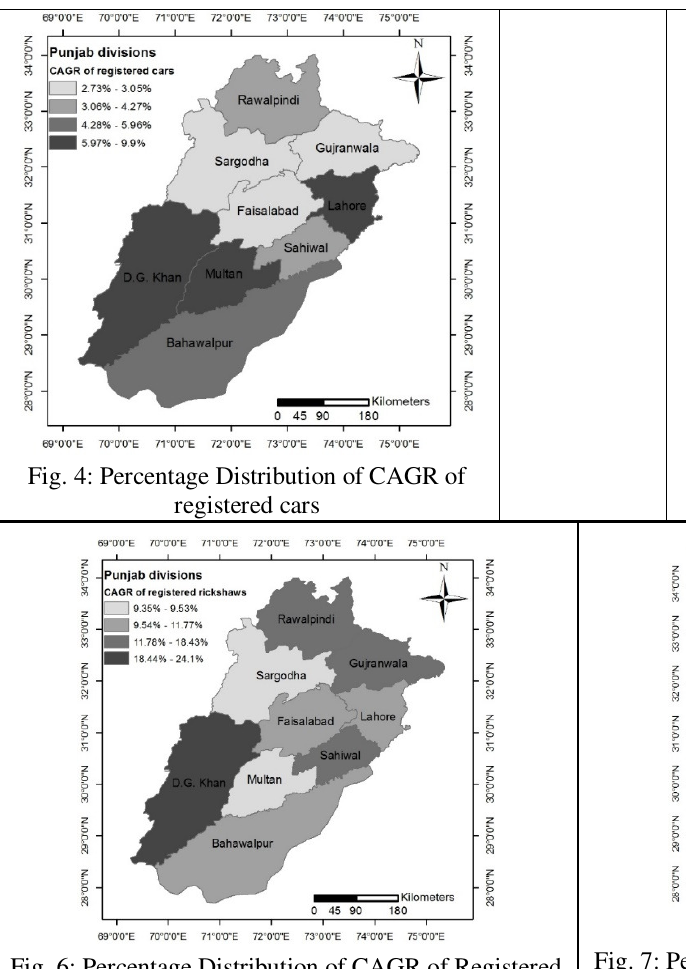
Fig. 6: Percentage Distribution of CAGR of Registered Rickshaws